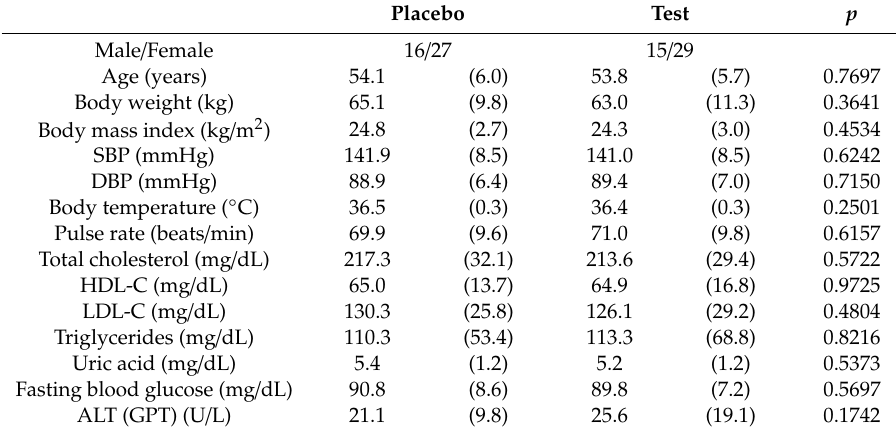
Table 2. Demographic characteristics and baseline data of the participants. Placebo Test p